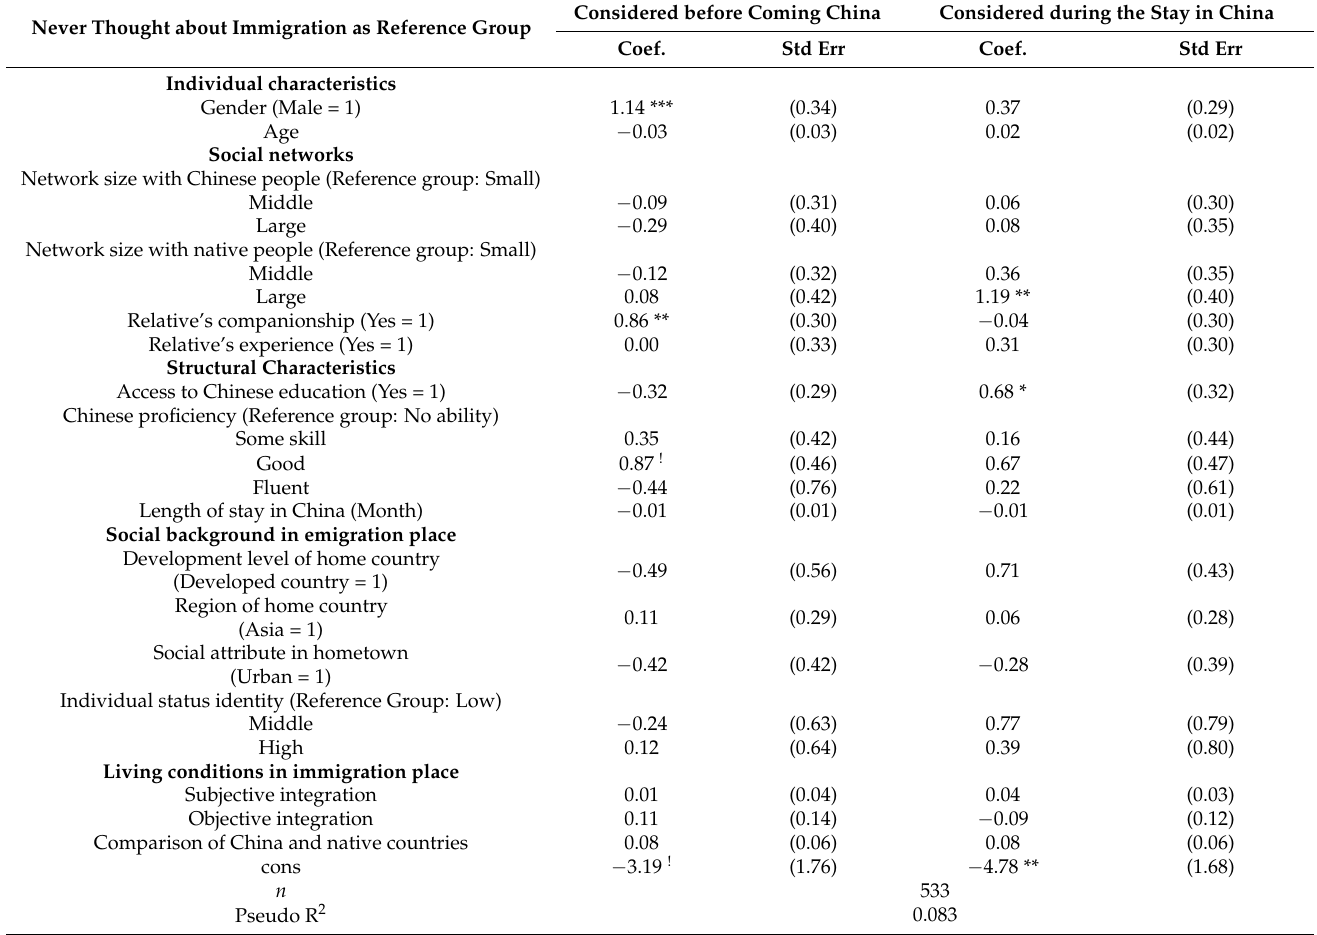
Table 6. Immigration Intention Model.(M-Logit Regression